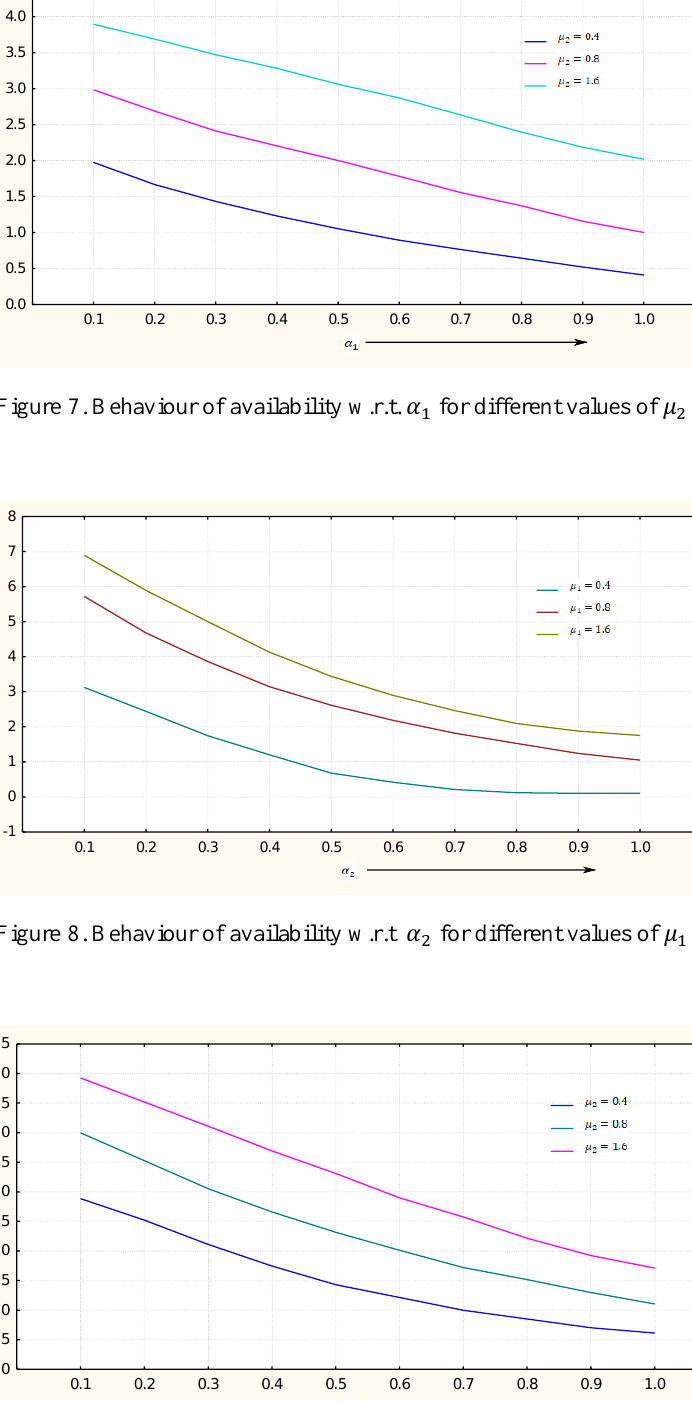
for different values of 𝜇 2